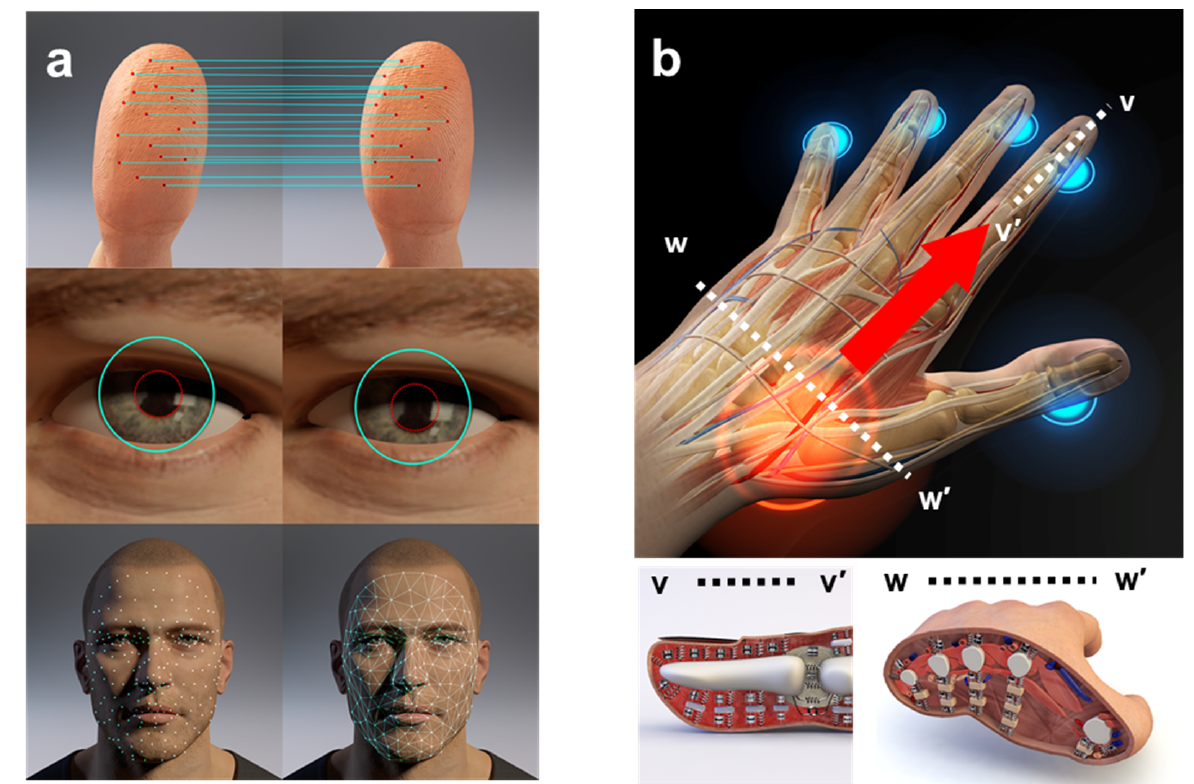
Figure 1. Conceptual diagram of the bioacoustics-based identity authentication approach. ( a ) Conventional biometrics comparing structural similarities between acquired images. ( b ) Proposed biometric authentication method using characteristics inside the body.